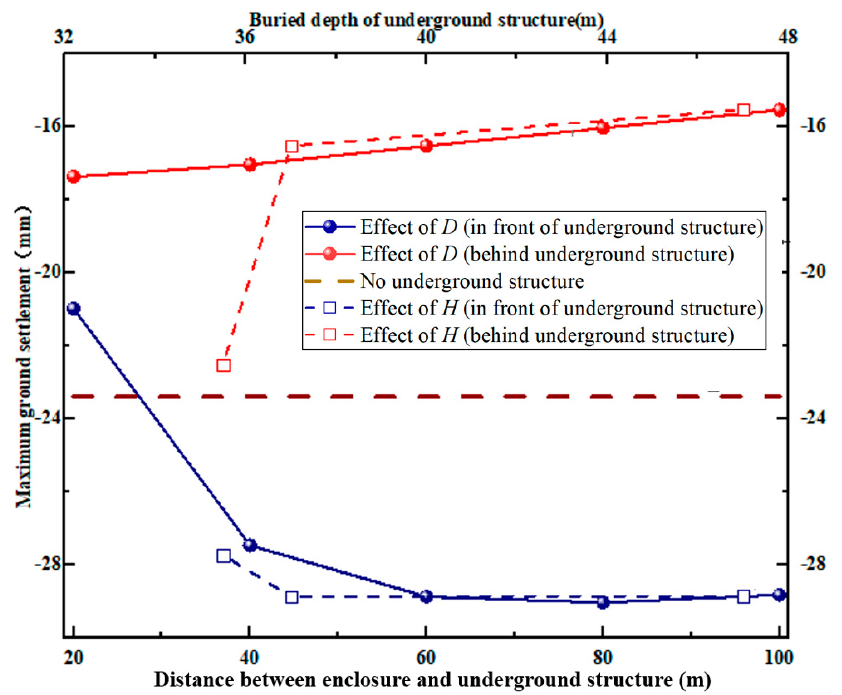
Figure 10. Influence of D and H on maximum ground settlement.